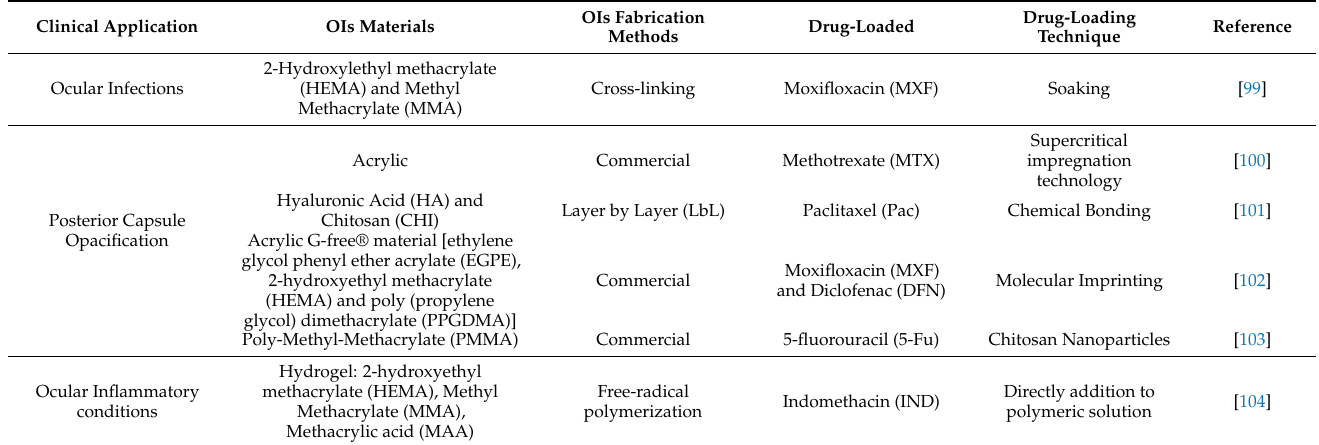
Table 3. Summary of the studies for drug-loaded